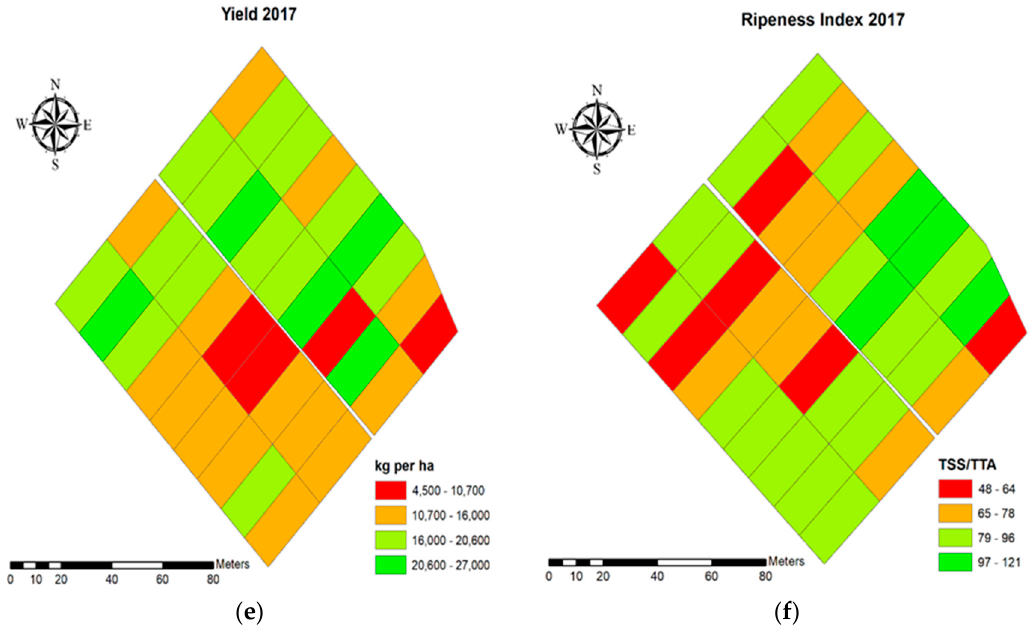
Figure 3. Maps of ( a ) yield 2015, ( c ) yield 2016, ( e ) yield 2017, ( b ) ripeness Index 2015, ( d ) ripeness Index 2016 and ( f ) ripeness Index 2017. The value ranges of all table grape parameters are presented according to the four quartiles.